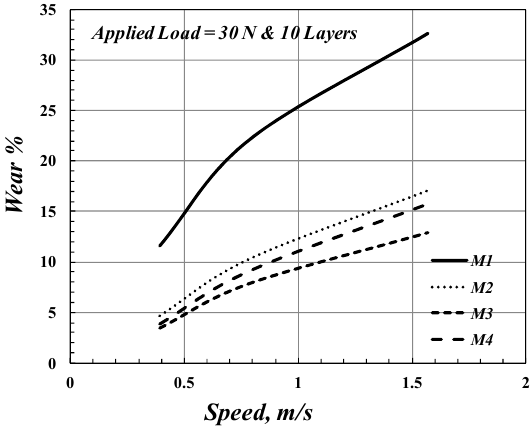
Figure 7. The effect of the speed on the wear rate.